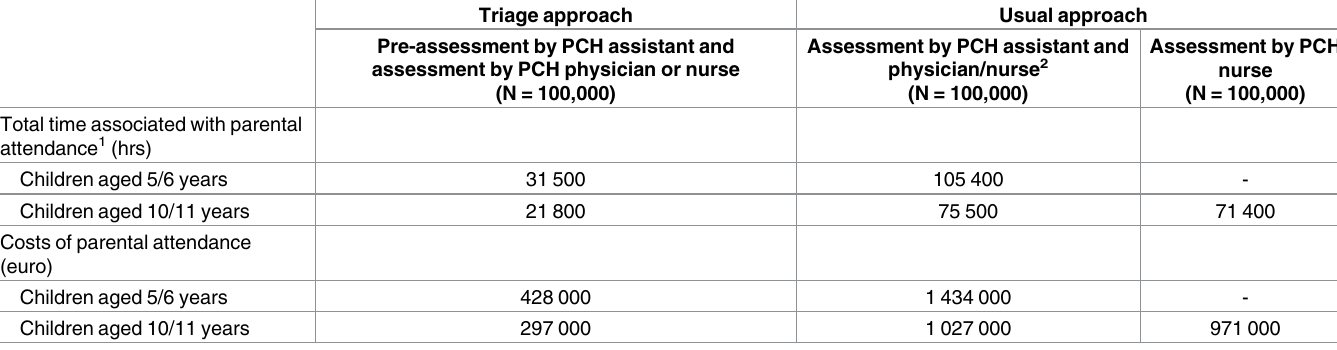
Table 4. Projected costs (2013 € ) associated with the time required for parental attendance at the assessmentsof their children aged 5/6 and 10/11 yearson the basis of a theoretical cohort of 100,000children per